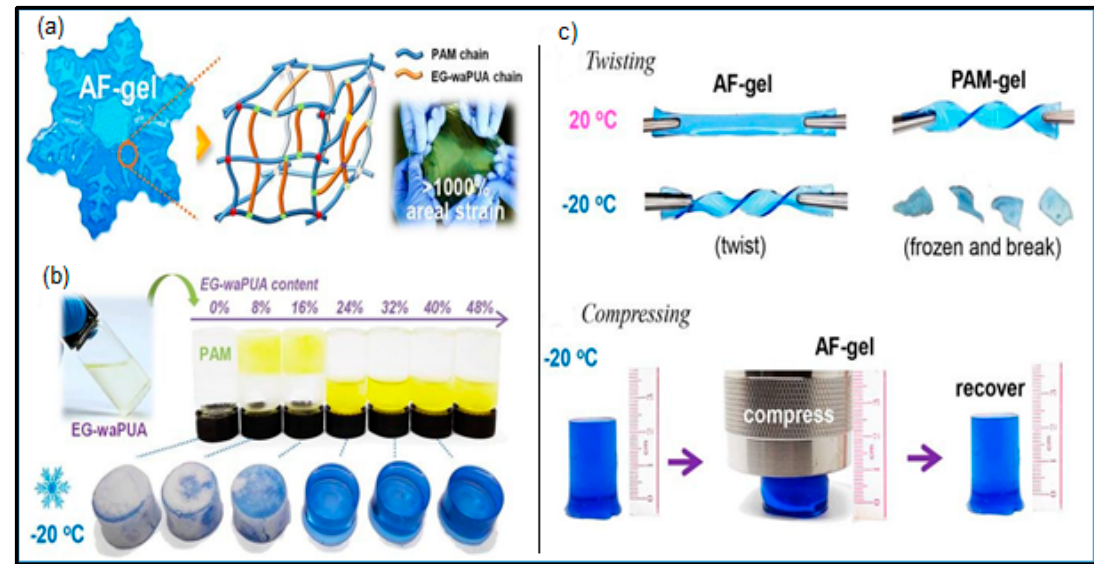
Figure 11. Characteristics of the AF gel electrolyte. ( a ) Optical images of the AF gel (colored blue for visibility) and a hypothetical molecular model. The soft hydrogel can be stretched more than 1000% in area without fracture. The dots with different colors indicate hydrogen bonds among different species ( b ) The effect of EG-waPUA weight percentage (Gw%) on the freeze-resistant performance of the hydrogel electrolyte after one day of cooling at − 20 °C. The EG-waPUA/water solutions were stained by yellow ink (0.1 wt.%). ( c ) Elastic stability of AF gel at − 20 °C. Reproduced with permission from [160]. Copyright 2019 Royal Society of Chemistry.